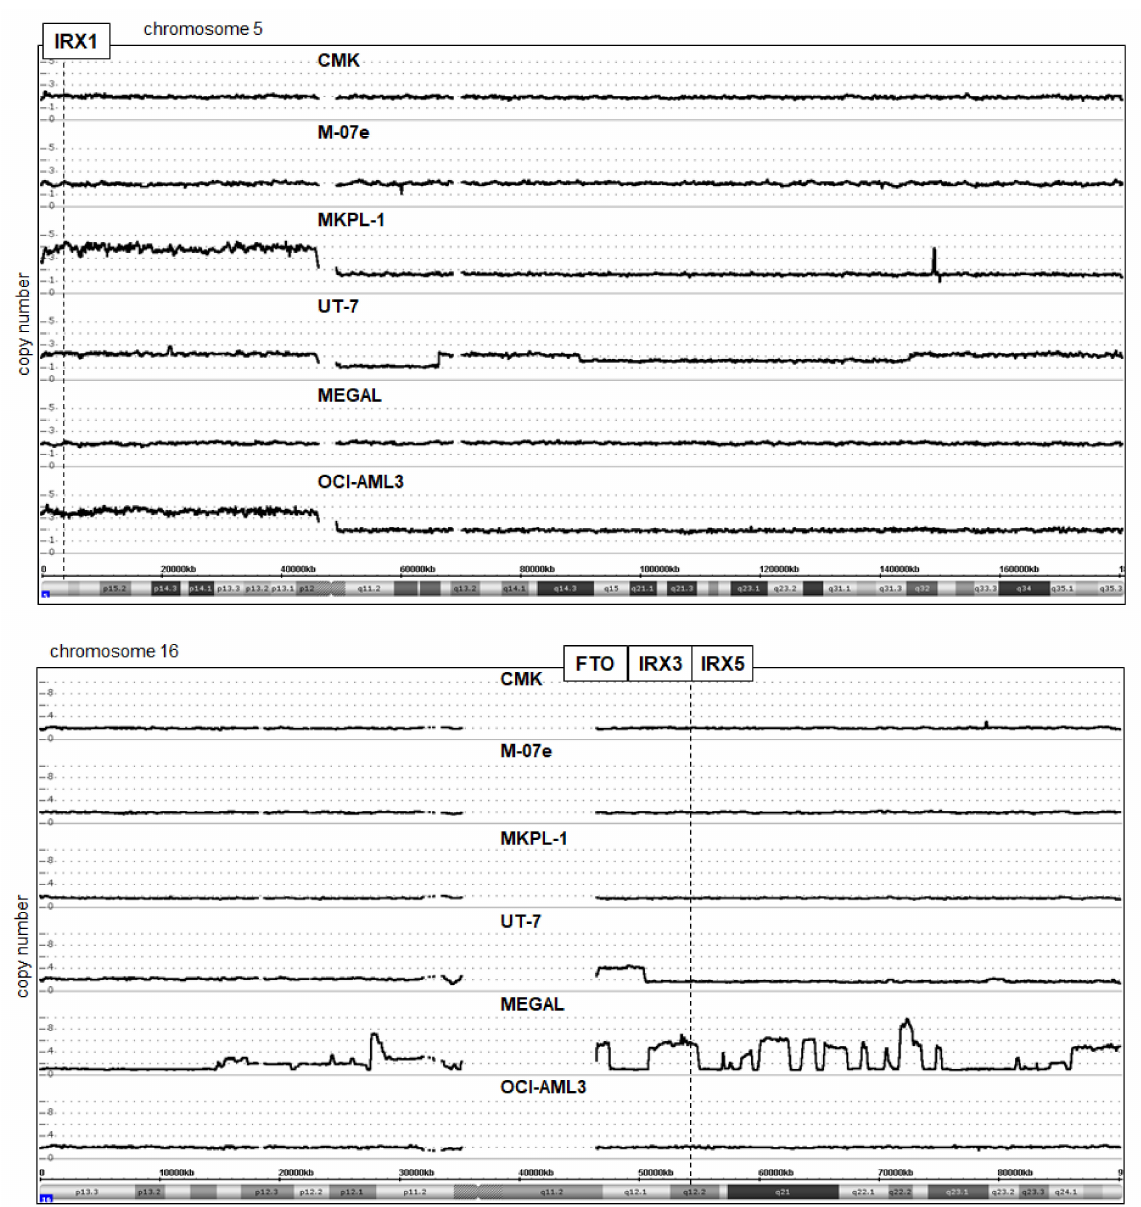
Figure 3. Genomic analysis of AML cell lines. Copy number states for chromosome 5 ( above ) and chromosome 16 ( below ) of IRX1-positive cell lines CMK, M-07e, MKPL-1, and UT-7, and of IRX3/IRX5-positive AML cell lines MEGAL and OCI-AML3 were determined by genomic profiling analysis. A copy number gain for IRX1 (located at 5p15) was detected in MKPL-1 and OCI-AML3. Amplification of FTO, IRX3, and IRX5 (16q12) was detected among multiple complex chromosome 16 rearrangements in